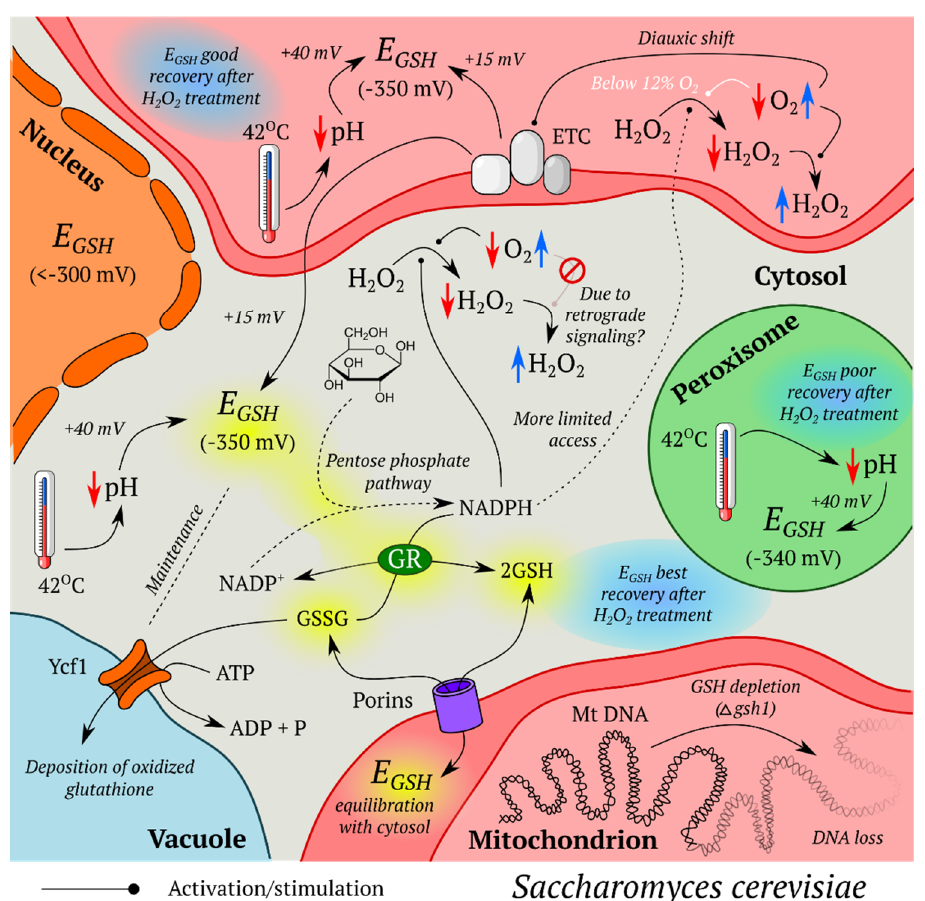
Figure 6. Compartment-specific features of selected redox processes in yeast cells. The picture summarizes the mechanisms of glutathione redox potential ( E GSH ) maintenance and its dependence on the temperature, as well as the dynamics of H 2 O 2 concentration shifts in response to changes in oxygenation degree in cytosol, mitochondria and peroxisomes [12,14,32,46,205,212]. Abbreviations: ETC—electron transport chain; GR—glutathione reductase; GSH—reduced glutathione; GSSG—